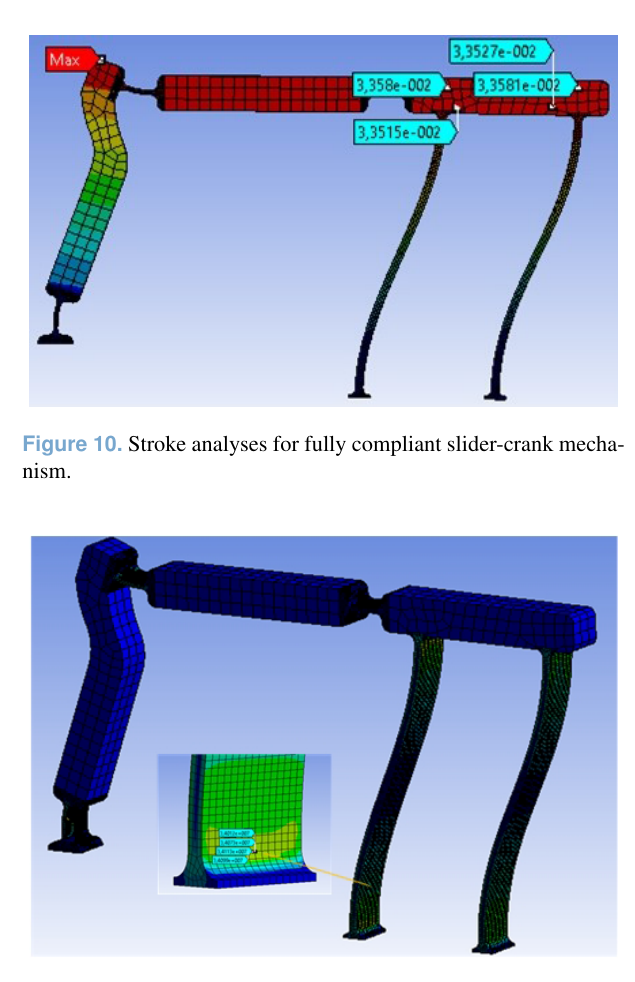
Figure 11. Maximum stress values at compliant segments for fully compliant slider-crank mechanism.